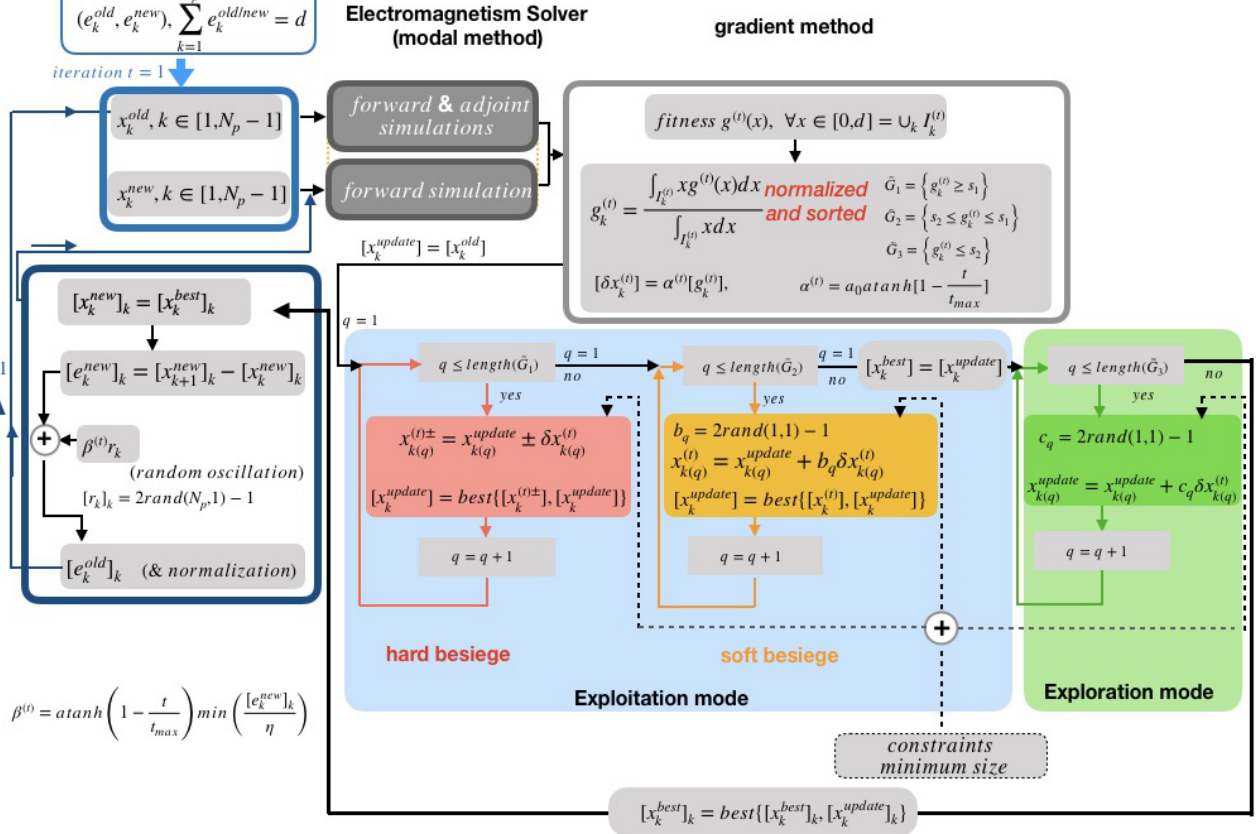
Figure 2. Flowchart of the proposed optimization method using a wolf pack biomimicry-gradient-based